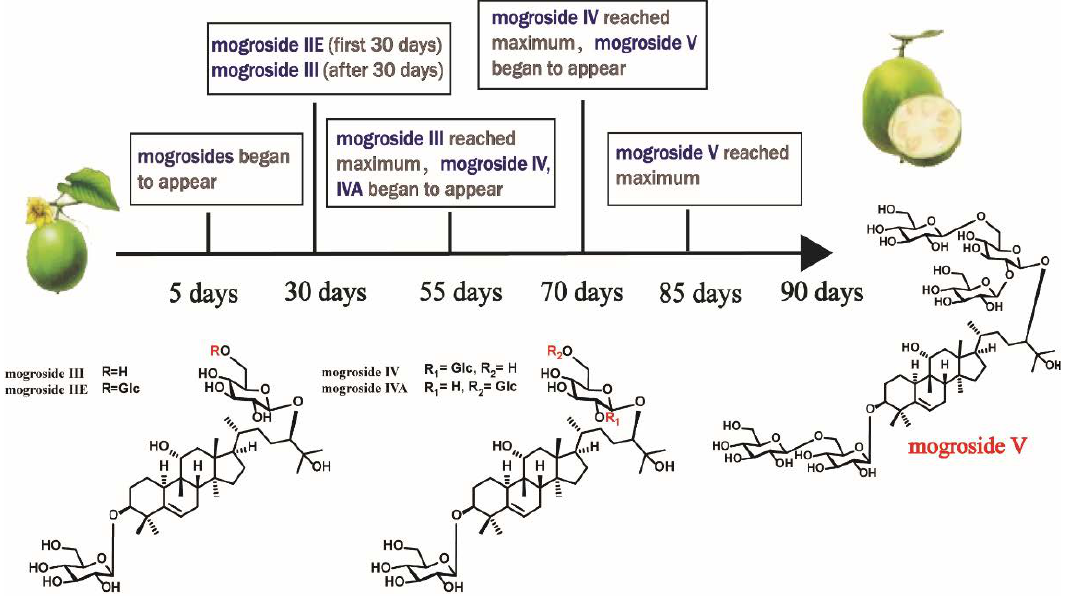
Figure 3. Structural changes in mogroside during different growth periods.